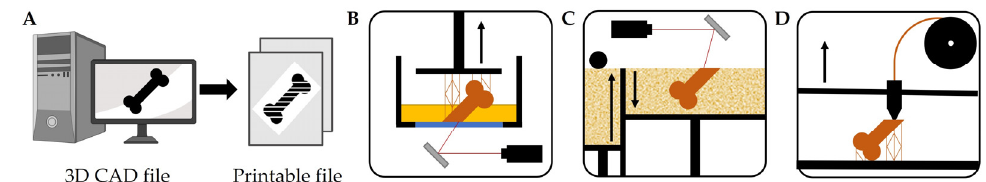
Figure 3. The three main methods for 3D printing. ( A ) Segmentation of a 3D CAD file into a format that allows a layer-by-layer reconstruction of the original volumetric body by 3D printing. ( B ) In stereolithography, the printing platform is submerged in a liquid monomer solution. The monomers are crosslinked into a polymer and hardened layer-by-layer by UV light, provided by a laser or LEDs. ( C ) In selective laser sintering, particles provided as a powder are fused layer-by-layer by laser light and a new powder is provided from a separated reservoir via a roller. ( D ) In fused deposition modelling, a layer-by-layer deposition of melted polymer filament is facilitated by using a thermal print head. Figure is partly adapted from [105]. Figure contains illustrations and icons created with BioRender.com (accessed on 8 December 2022).